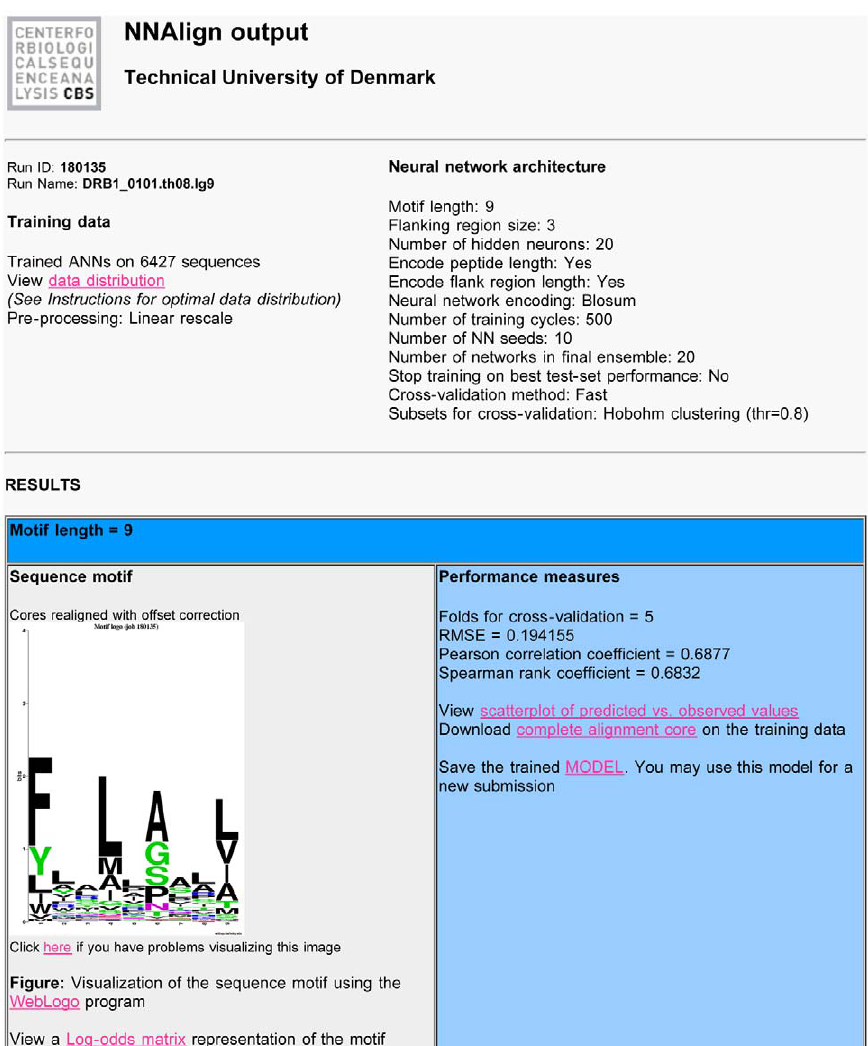
Figure 1. Example of output from the NNAlign server trained on MHC class II binding data for allele HLA-DRB1*0101. Links on the results page (in pink) redirect to additional files and figures relevant for the analysis. Run ID is a sequential identifier for the current job, and Run Name a user-defined prefix that is added to all files of the run. The ‘‘view data distribution’’ link shows the transformation applied to the data in pre- processing, which can be either a linear or logarithmic transformation. In this case the method was trained with a motif length of 9, including a PFR of size 3 to both ends of the peptide, and encoding in the network input layer peptide length and PFR length. The hidden layer was made of a fixed number of 20 neurons. Peptides were presented to the networks using a Blosum encoding to account for amino acid similarity, for 500 hundred iterations per peptide without stopping on the best test set performance. At each cross-validation step, 10 networks were trained starting from 10 different initial configurations. The subsets for cross-validation were constructed using a Hobohm1 method that groups in the same subset sequences that align with more than 80% identity (thr=0.8). The model can be downloaded to disk using the dedicated link, and can be resubmitted to NNAlign to find occurrences of the learned pattern in new data. The estimated performance of the trained method is expressed in terms of Root Mean Square Error, Pearson and Spearman correlation. A visual representation of the correlation can be obtained from the scatterplot of predicted versus observed values. The ‘‘complete alignment core’’ link allows downloading the prediction values in cross-validation for each peptide, and where the core was placed within the peptides. Next follows a section on the sequence logo, showing a logo representation of the binding motif learned by the network ensemble. If the relative option is selected, links to logos for the individual networks in the final ensemble are also listed here. Finally,